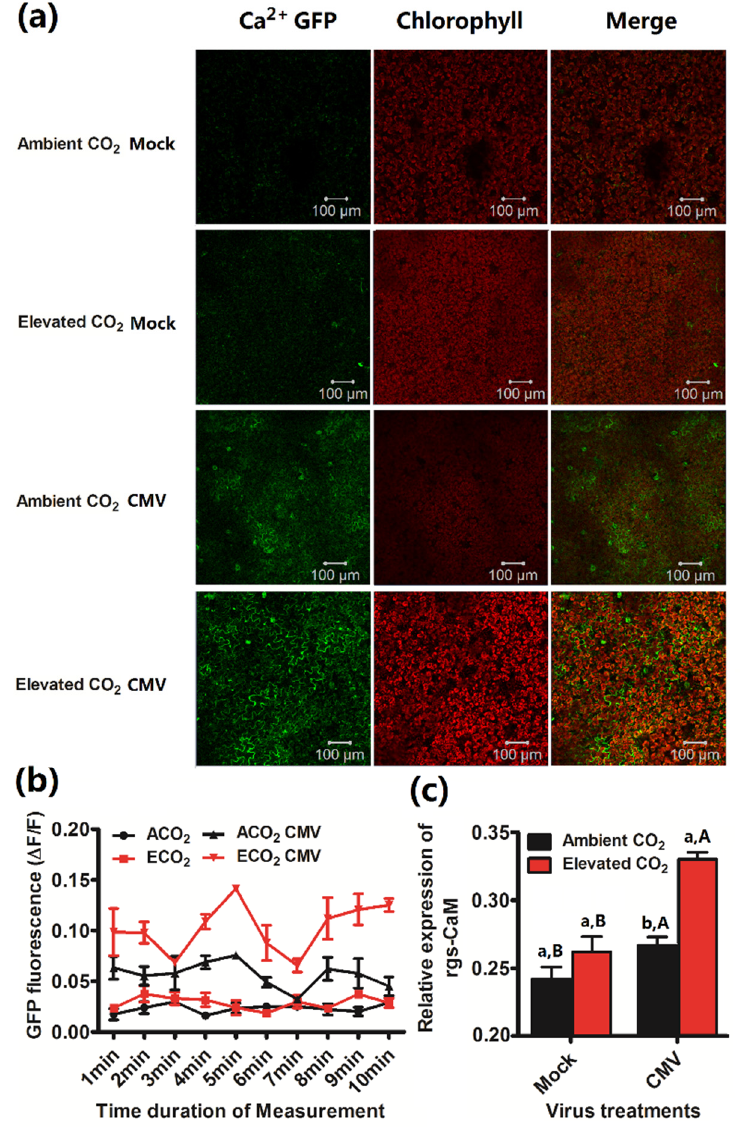
Figure 4. Elevated CO 2 increased [Ca 2+ ] cyt of N.tabacum and the relative expression of rgs-CaM when infected by CMV. ( a ) Sub-cellular localization of GFP fluorescence of Ca 2+ in CMV-infected and mock-inoculated leaves in GCaMP3 transgenic N. benthamiana plants post infection for 2 weeks under both CO 2 levels. Images of the probe (green) and chlorophyll (red) fluorescence emission are shown together with overlay images of these two pictures—100 µ m. ( b ) Normalized fluorescence ( ∆ F/F) of 35S:GCaMP3 leaves post infection for 2 weeks. ∆ F, difference between measured fluorescence of treated plants and baseline fluorescence (F) of healthy plants. ( c ) the relative expression of rgs-CaM mRNA in wild-type N. tabacum post agroinoculated with buffer (Mock) or CMV for 14 days under ambient CO 2 and elevated CO 2 . Data represent means ± SE (Tukey’s multiple range test, p < 0.05). Different lowercase letters indicate significant differences between ambient CO 2 and elevated CO 2 within the same virus treatment. Different uppercase letters indicate significant differences between virus treatments within the same CO 2 treatment ( p < 0.05).